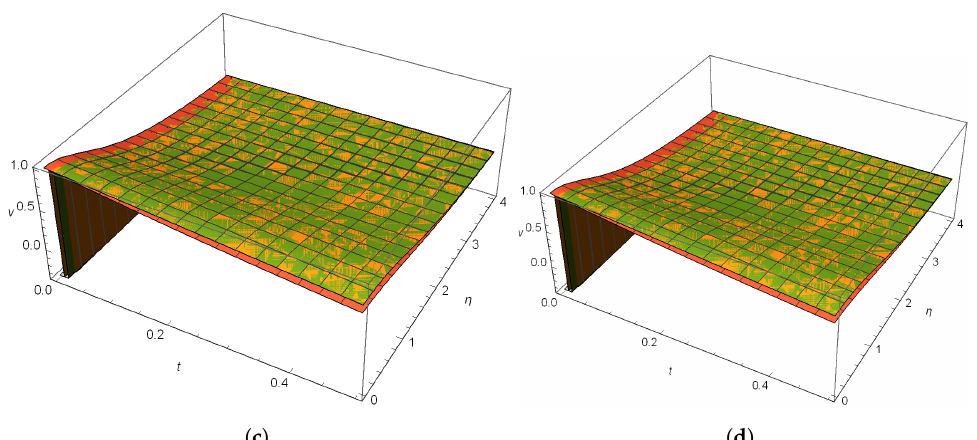
Figure 3. 3-D Plot of α -HATM solution for YAC operator with exact solution for case 3 when γ = 0.99. ( a ) α -HATM solution with exact solution. ( b ) α -HATM solution with exact solution for distinct values of k, Yellow (k = − 0.6), Blue (k = − 0.8), Green (k = − 1), Red (Exact Solution). ( c ) α -HATM solution with exact solution for distinct values of r, Yellow (r = 1), Blue (r = 2), Green (r = 3), Red (Exact Solution). ( d ) α -HATM solution with exact solution for distinct values of χ , Yellow ( χ = 1), Blue ( χ = 2), Green ( χ = 3), Red (Exact